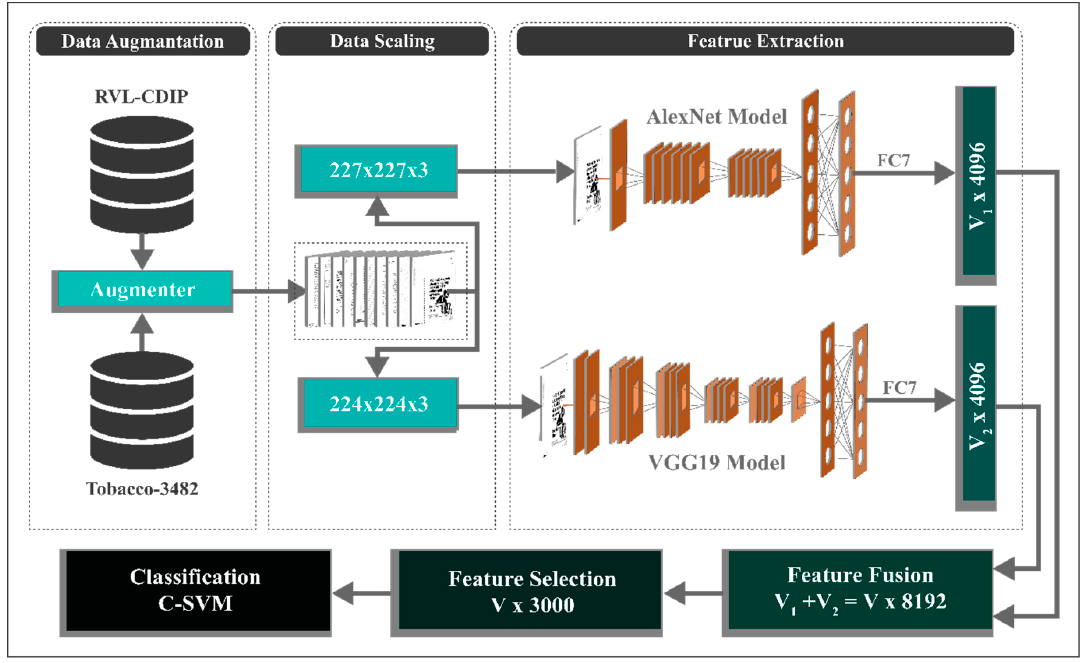
Figure 1. Detailed model of the proposed method. Table 1. Nomenclature of variables used in the definitions and equations.